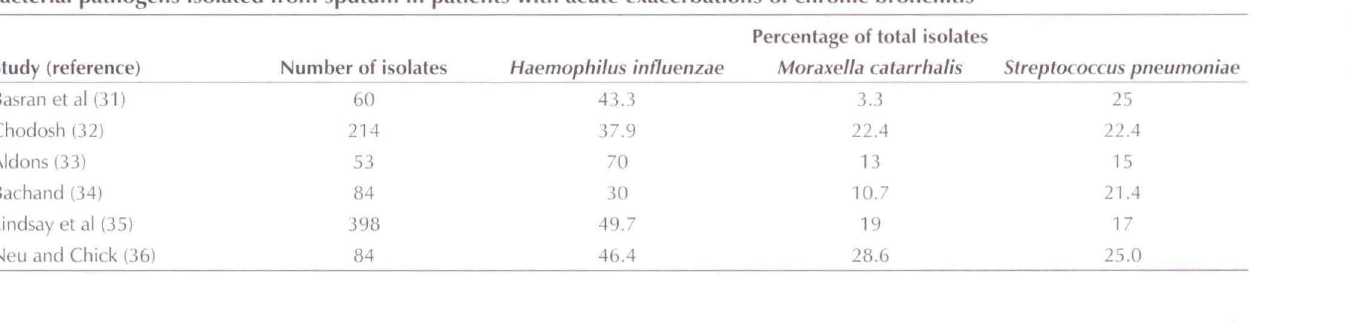
Bacterial pathogens isolated from sputum in patients with acute exacerbations of chronic